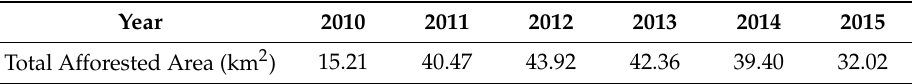
Table 7. The total afforested area in Zhejiang Province from